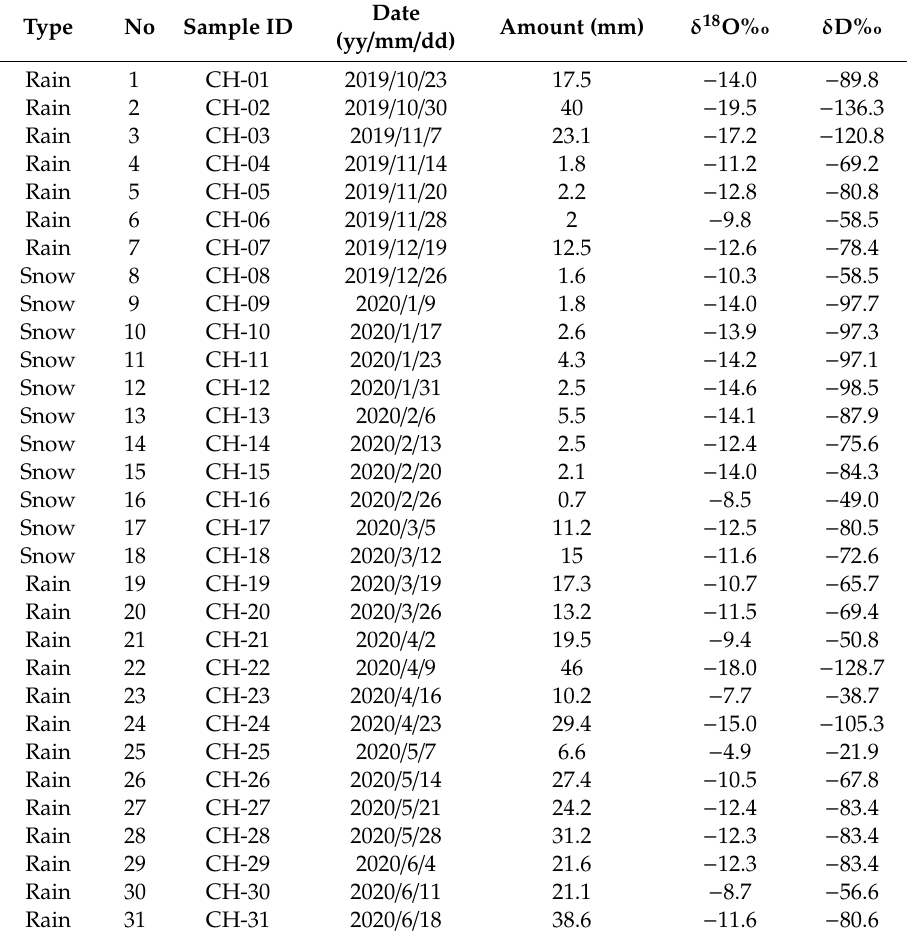
Table 2. δ 18 O and δ 2 H isotopes of precipitation at the Changhai Lake precipitation